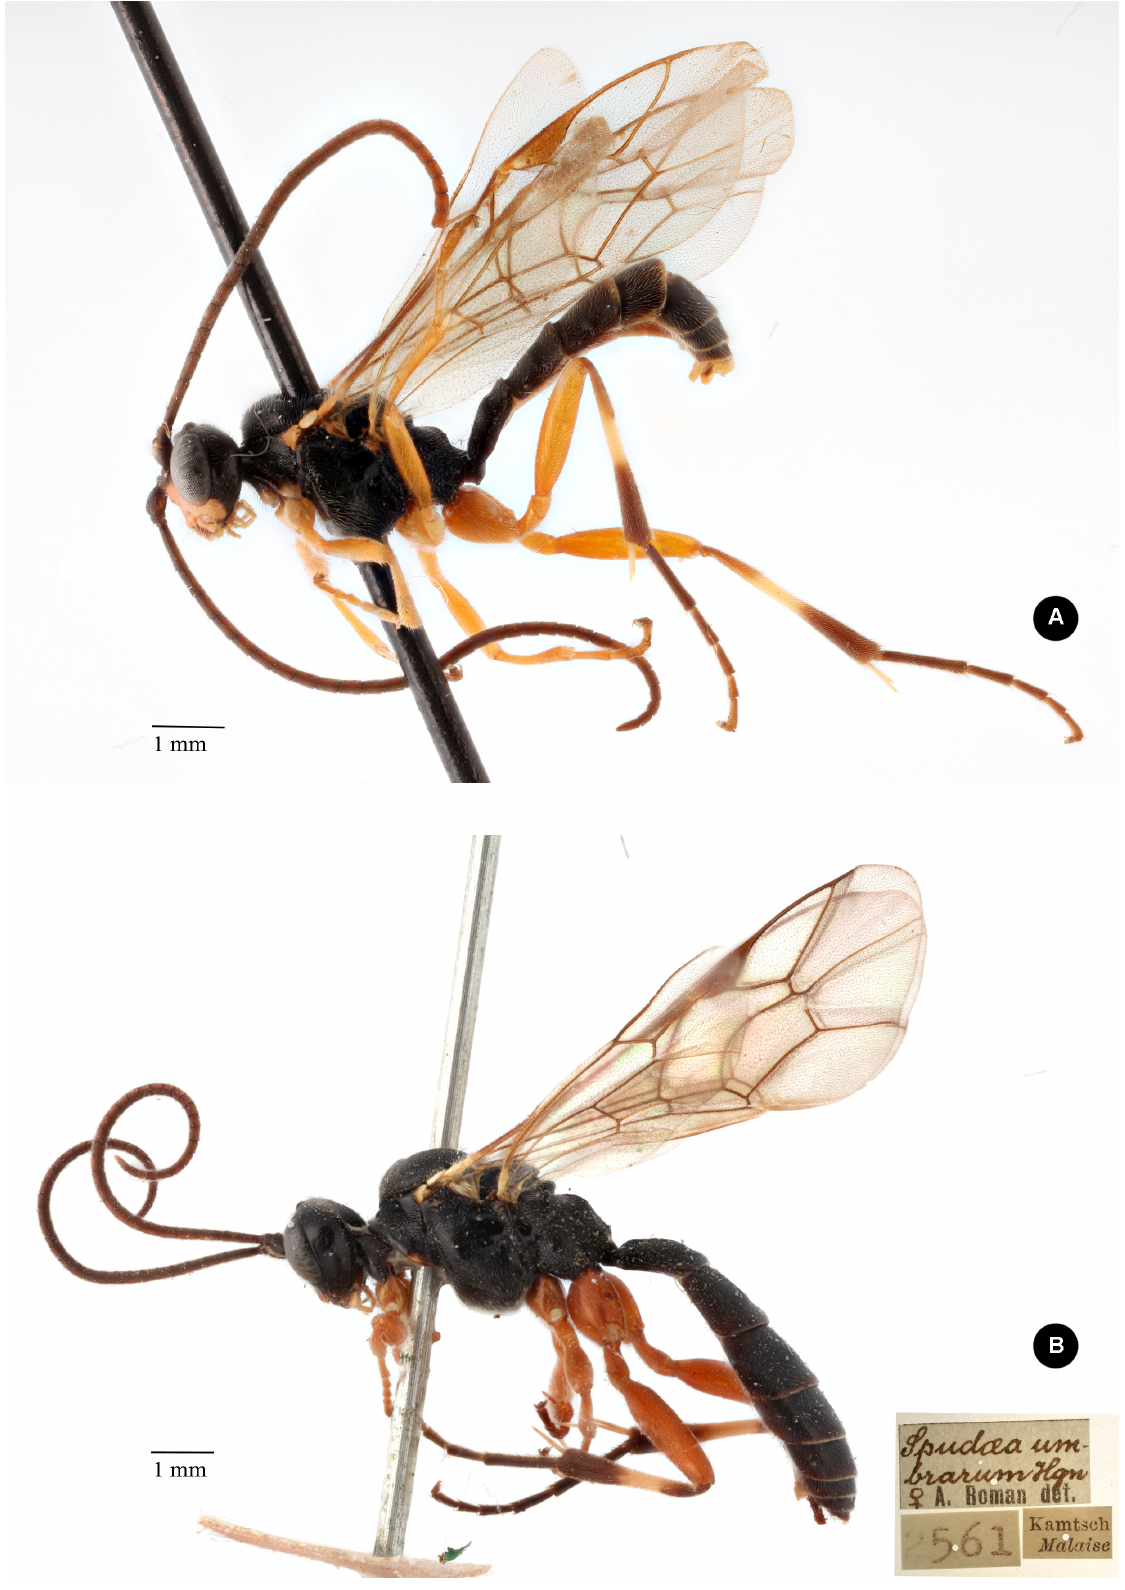
Fig. 14. Rhinotorus umbrarum (Holmgren, 1857). A . ♂, habitus. B . ♀,